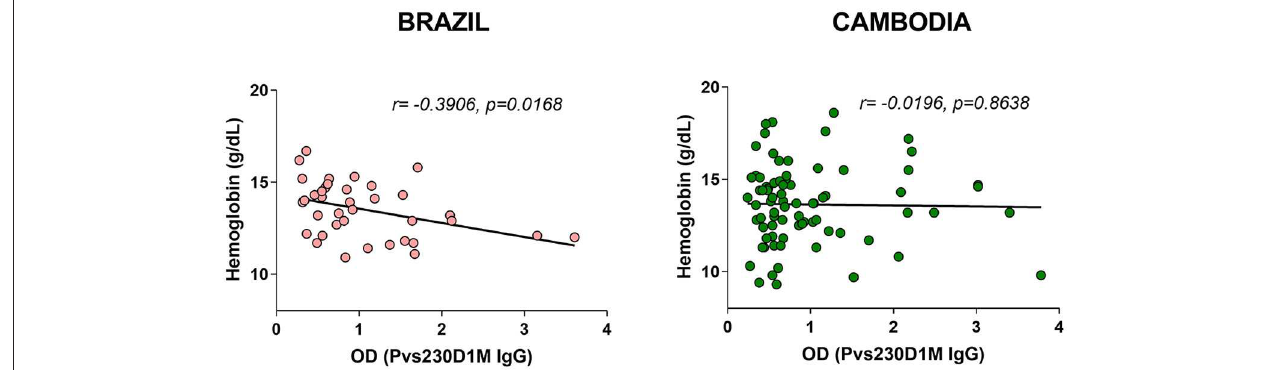
FIGURE 6 | Pvs230D1M-specific antibody responses inversely correlate with hemoglobin levels in Brazil but not in Cambodia.